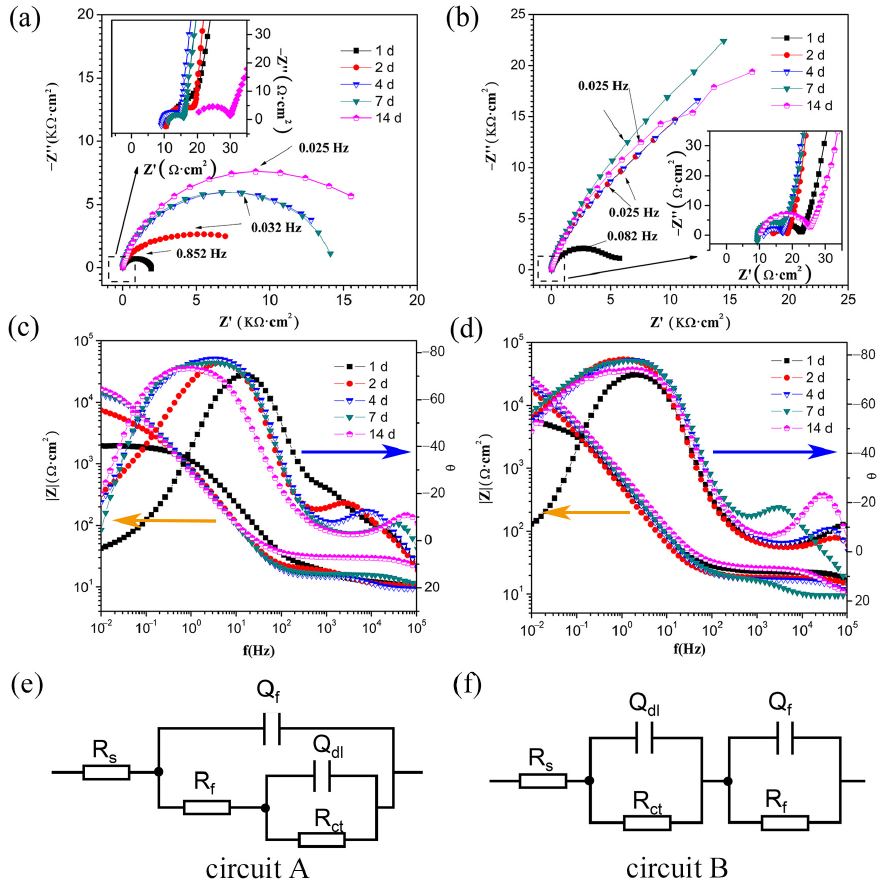
Figure 6. Nyquist and Bode plots for the Q235 in ( a , c ) the sterile media and ( b , d ) the SRB-Z-inoculated media, and ( e , f ) equivalent circuits used for fitting the EIS spectra of Q235. Table 4. Fitted parameters of